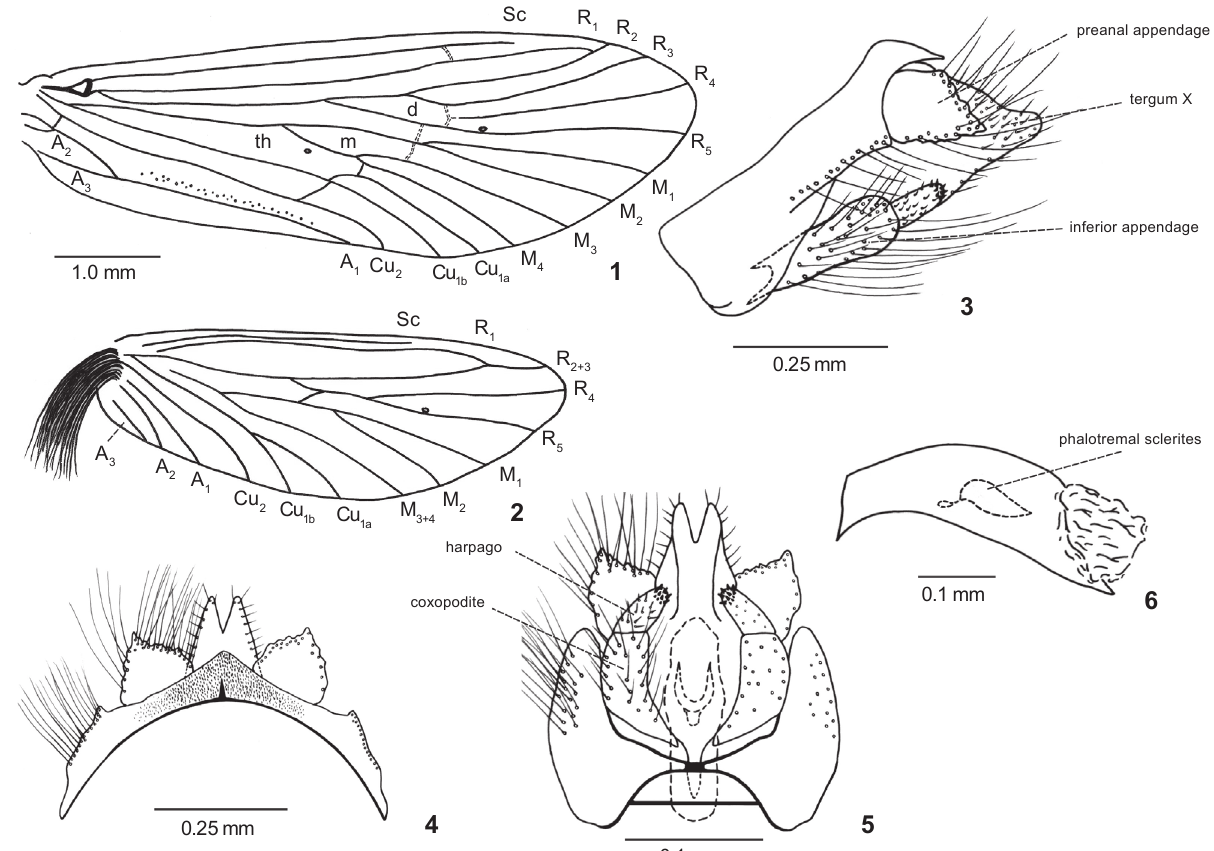
Figures 1-6. Phylloicus monneorum sp. nov. , male. (1-2) Wings: (1) forewing; (2) hindwing. (d) Discoidal cell, (m) medial cell,